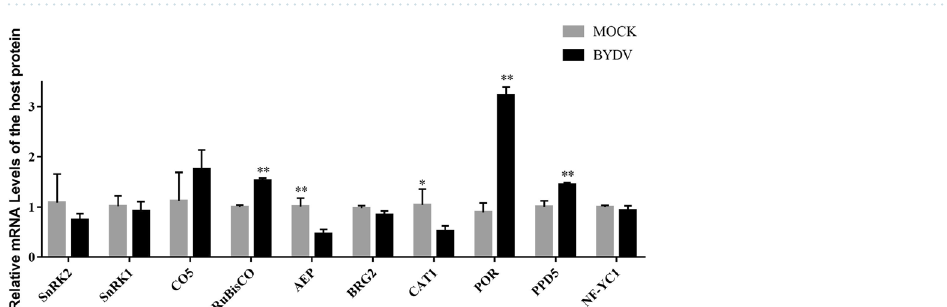
Figure 7. Detection of differentially expressed 17K-interacting host factors under BYDV-GAV infection by qRT-PCR. The relative expression levels of 17K-interacting host factors in mock- and BYDV infected N. benthamiana leaves at 5 dpi using qRT-PCR. Data were pooled across experiments and analyzed using t -tests. Bars represent the grand means ± standard deviation (SD). *, P < 0.05; **, P <